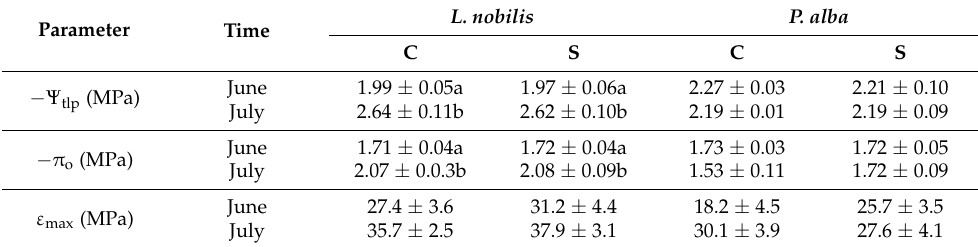
Table 3. Mean ± SEM (n = 5) of leaf water potential at turgor loss point ( − Ψ tlp ), osmotic potential at full turgor ( − π o ) and bulk modulus of elasticity ( ε max ) as recorded in June (before starting drought treatment), and in July (at the end of the experimental period) in control (C) and shaded (S) samples of L. nobilis and P. alba plants. Different letters indicate statistically significant differences based on two-way ANOVA. L. nobilis